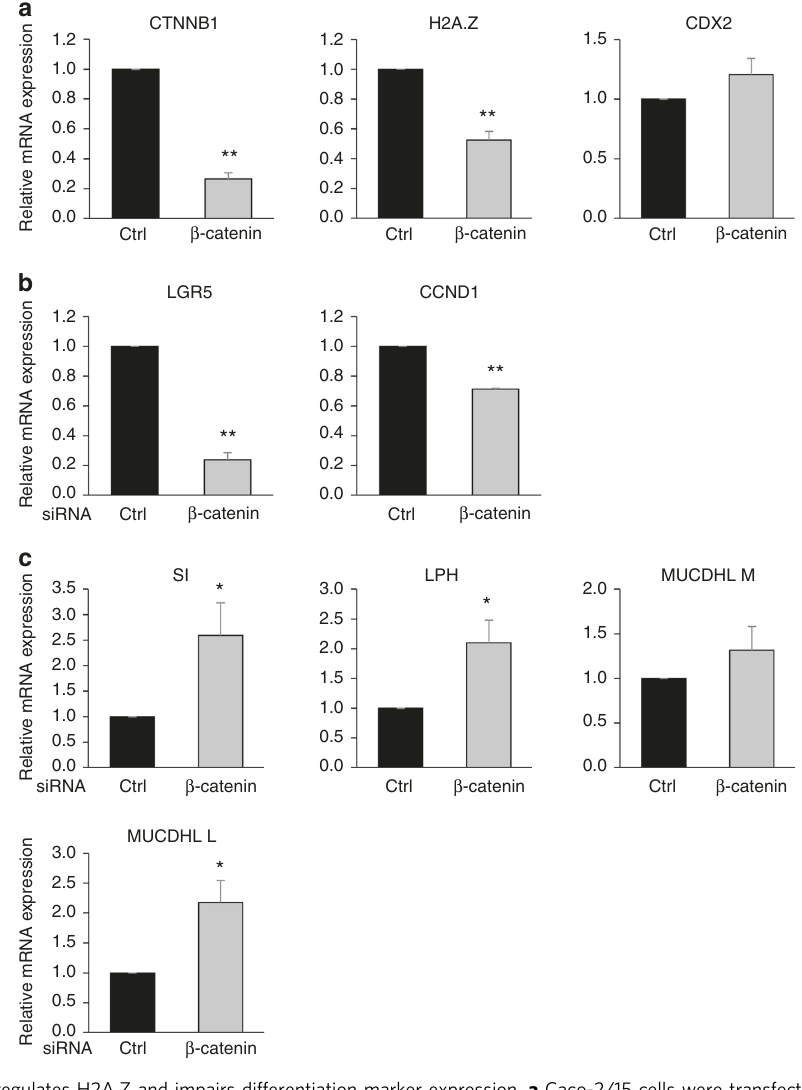
Fig. 6 β -catenin positively regulates H2A.Z and impairs differentiation marker expression. a Caco-2/15 cells were transfected using siRNA targeting β - catenin mRNA or control. 72 h later, total RNA was extracted and subjected to RT-qPCR analysis for expression of the indicated genes (calculated relative to β 2 M and RPLP0 (p0) mRNA levels). The mean and standard errors are shown ( n = 4 independent experiments). Statistical analysis was done using Student ’ s t -Test (** p < 0.02 vs control siRNA). b Same as in a for Wnt target genes (** p < 0.02 vs control siRNA). c Same as in a for enterocytes differentiation marker genes (* p < 0.05 vs control